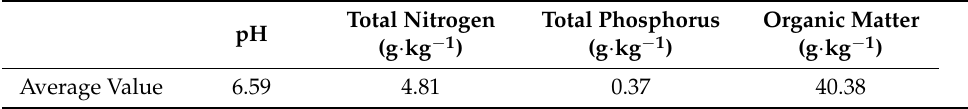
Table 1. Basic physical and chemical properties of gangue-containing